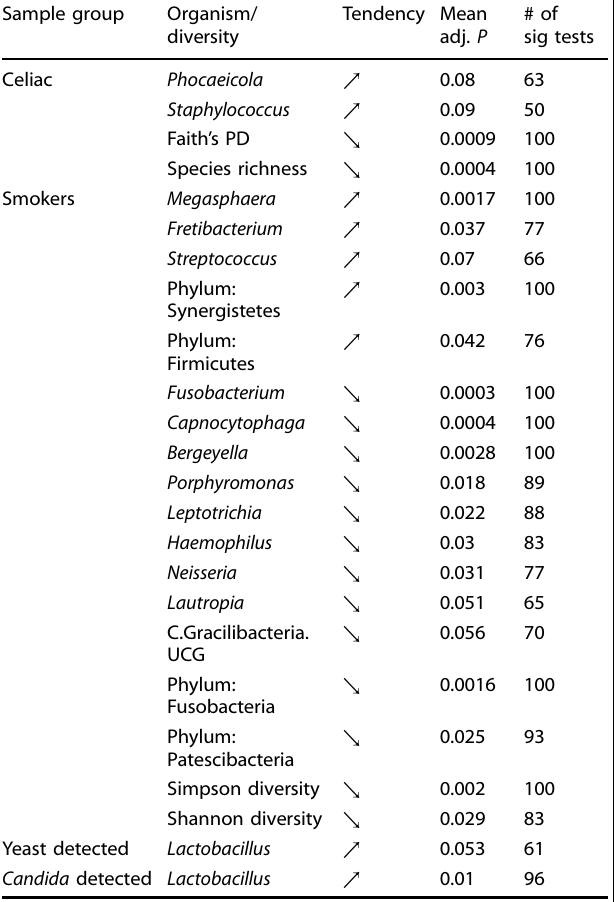
Table 2. Signi fi cance of differentially abundant taxa and alpha diversity measures between indicated variable and matched